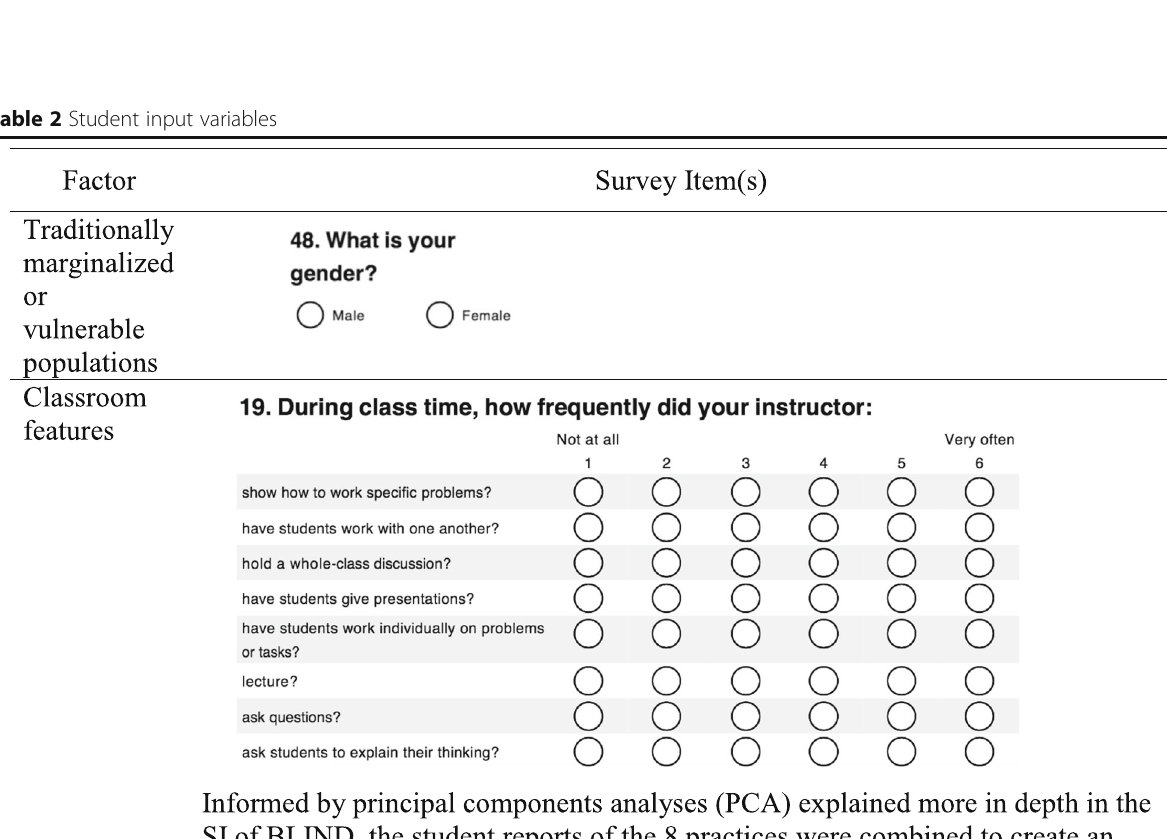
Fig. 3 Student output variable. Responses were binned as “ disagree ” ={strongly disagree, disagree, slightly disagree} and “ agree ” ={slightly agree, agree, strongly